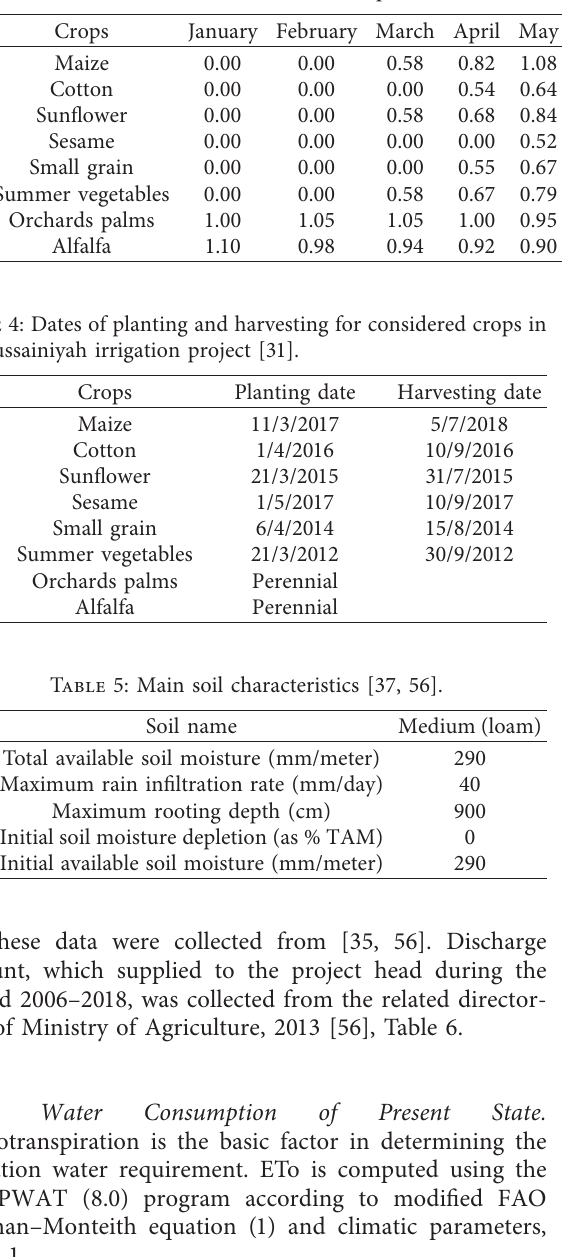
Table 3: Values of the crop coefficient, Kc, for crops of Al-Hussainiyah irrigation project [34].